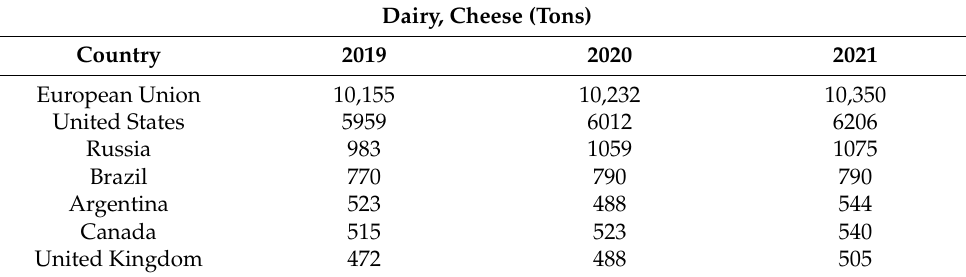
Table 1. Tons of cheeses produced by the main world countries. Dairy, Cheese (Tons)